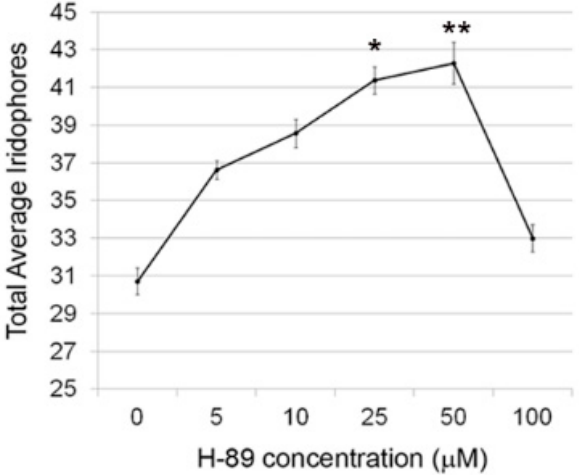
Figure 2. H89 treatment increases iridophore number in zebrafish larvae at 4 dpf. Quantification of iridophores following treatment of wildtype embryos with varying doses of the protein kinase A (PKA) inhibitor H89. One-way ANOVA with Bonferonni multiple comparison post-test indicates that doses of 25 µM and 50 µM are statistically significant (* p < 0.05 or ** p < 0.01).